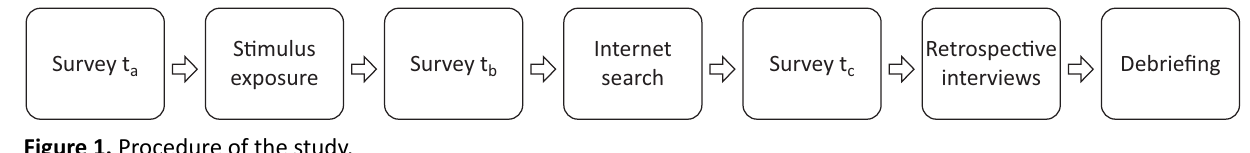
Figure 1. Procedure of the